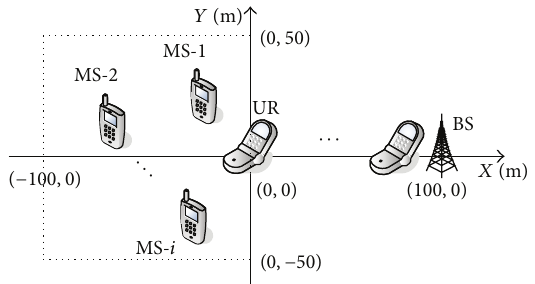
Figure 2: The simulated network